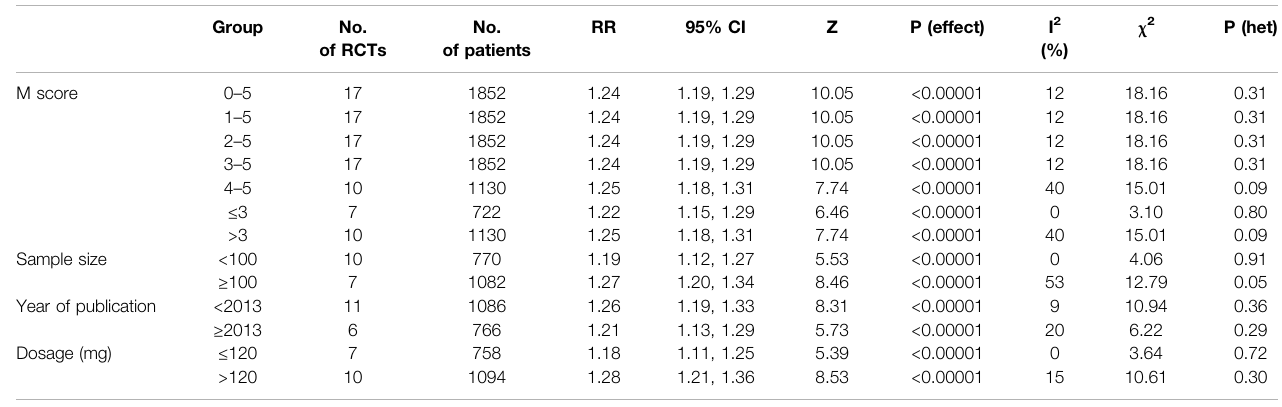
TABLE 3 | Sensitivity and subgroups analysis based on clinical effective rate.